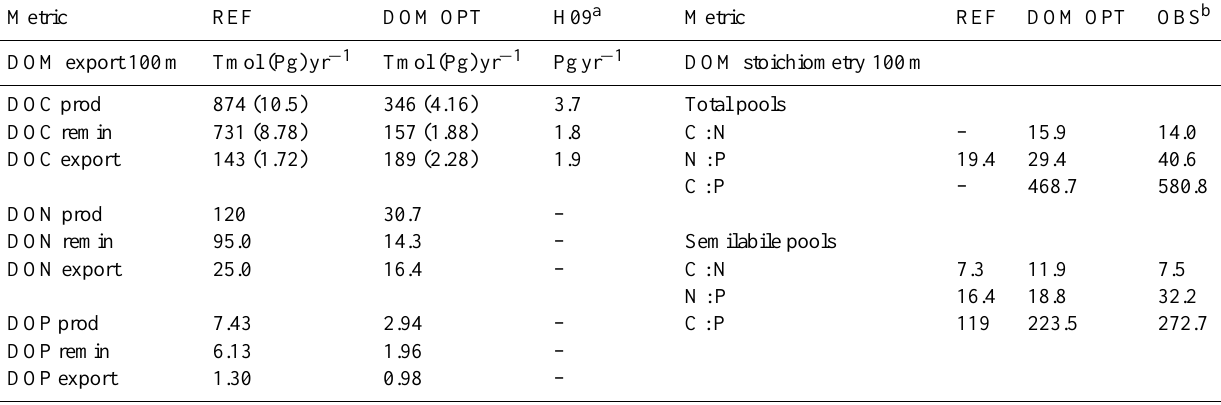
Table 2. DOM production, export, and stoichiometry metrics for the REF and DOM OPT simulations against observational constraints. Metric REF DOM OPT H09 a Metric REF